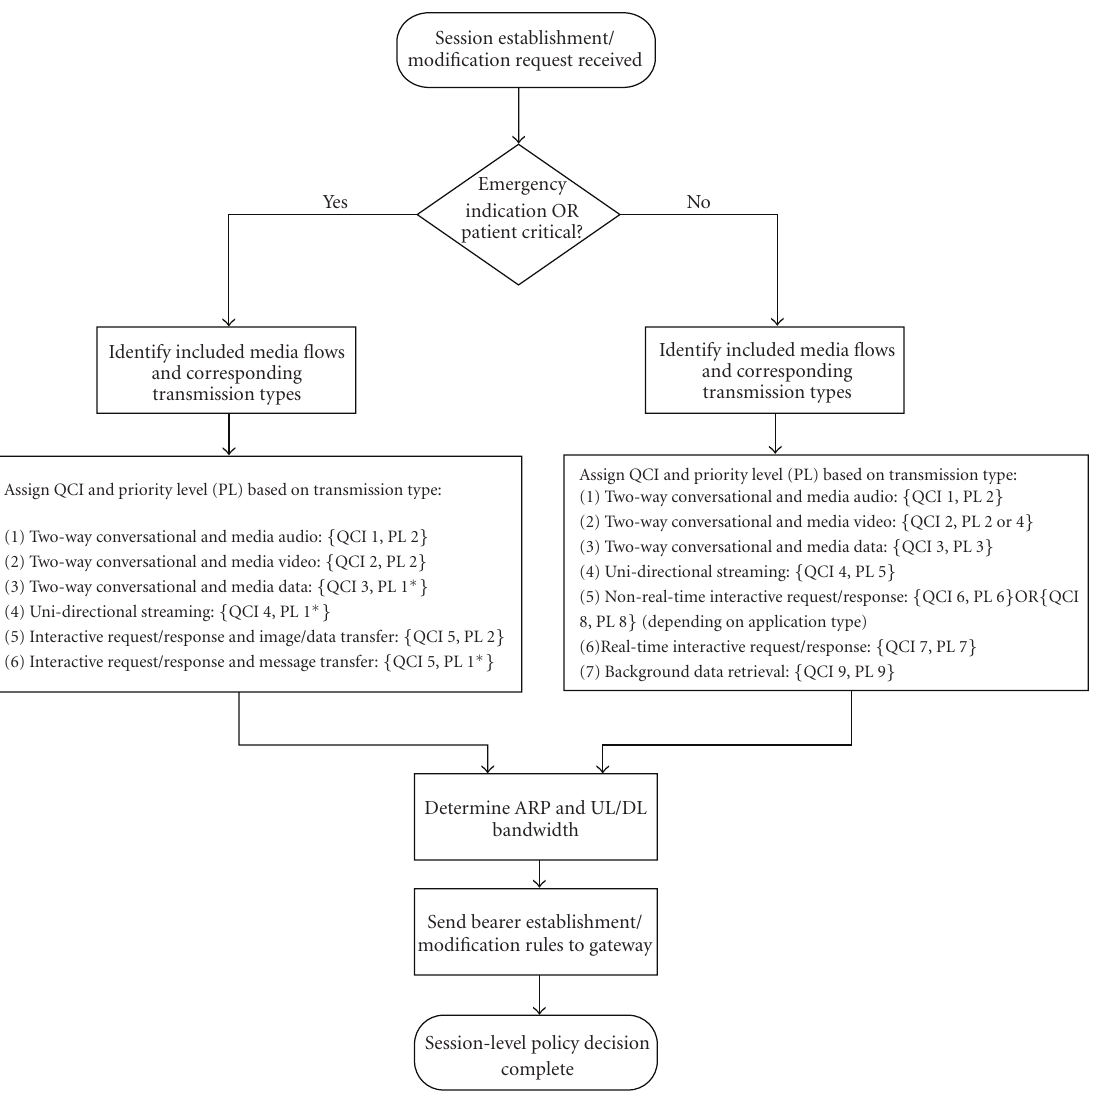
Figure 3: Scheme for assigning QCIs and priority levels to e-Health service